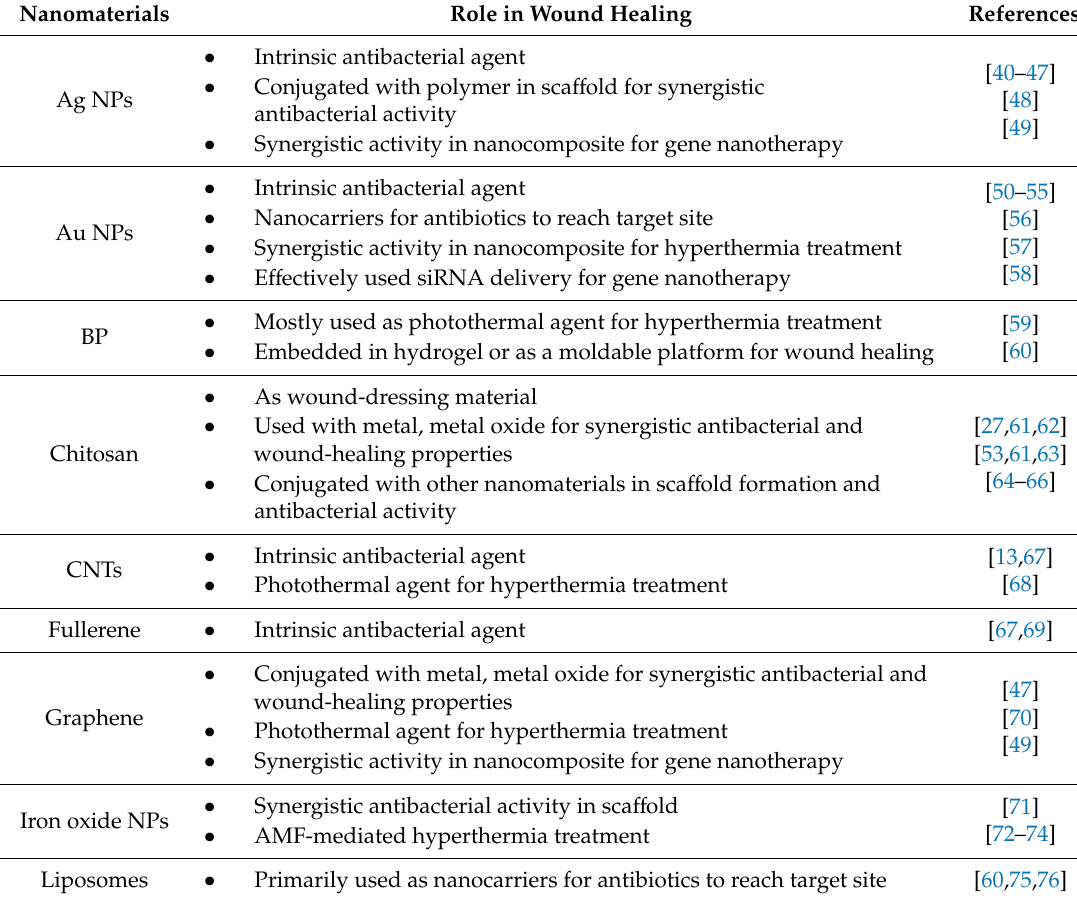
Table 2. Various nanomaterials and their role in wound